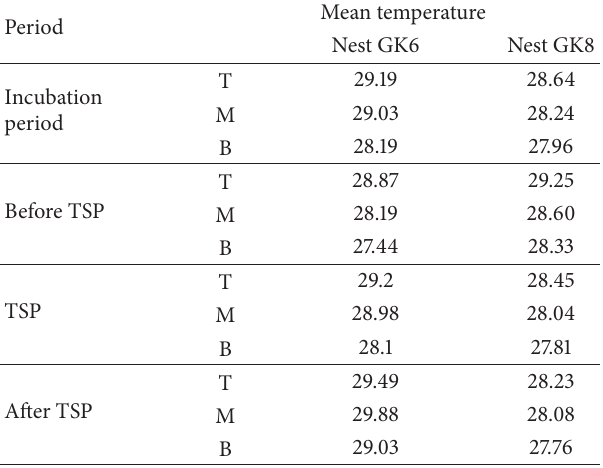
Table 3: Mean temperature ( ∘ C) in different parts of the nests GK6 andGK8duringtheincubationperiod.T,top;M,middle;B,bottom; and TSP, thermosensitive period.